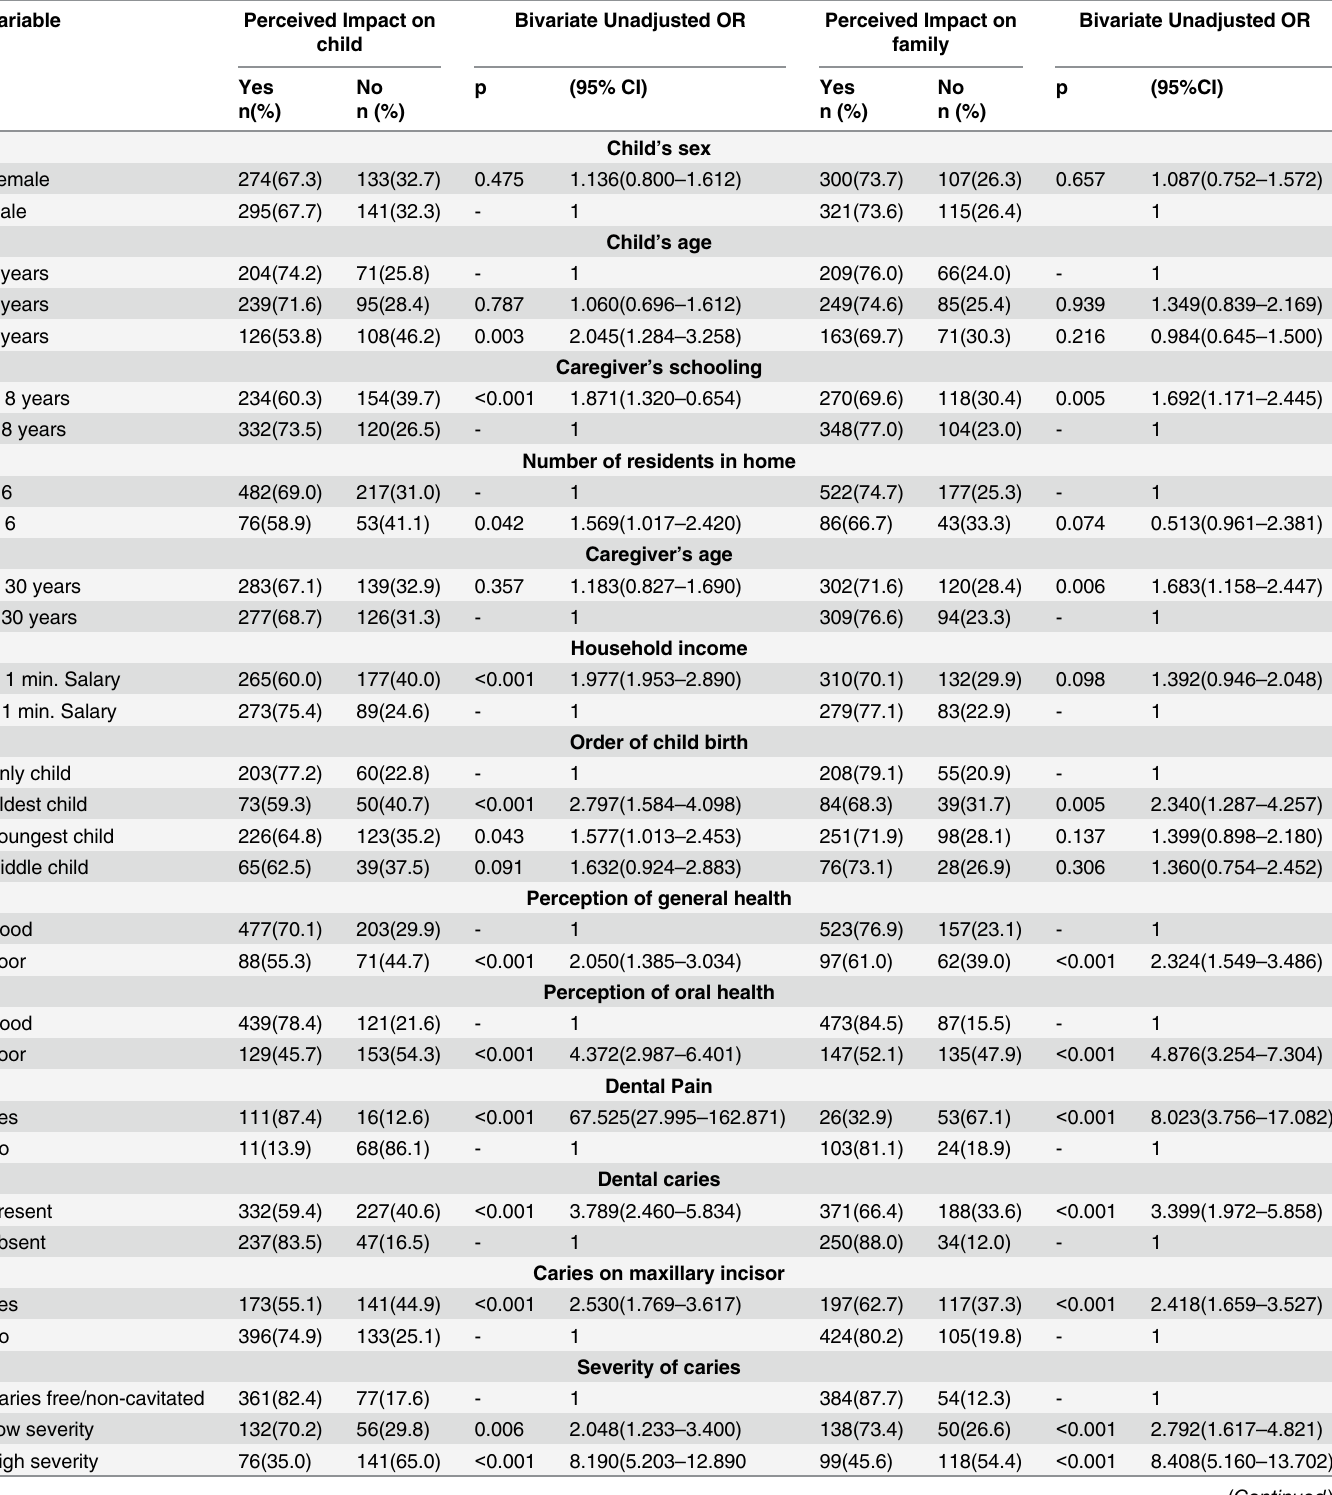
Table 3. Bivariate logistic regression models for the perceived impact of dental caries in the quality of life of pre-school children, their families and the independent variables.